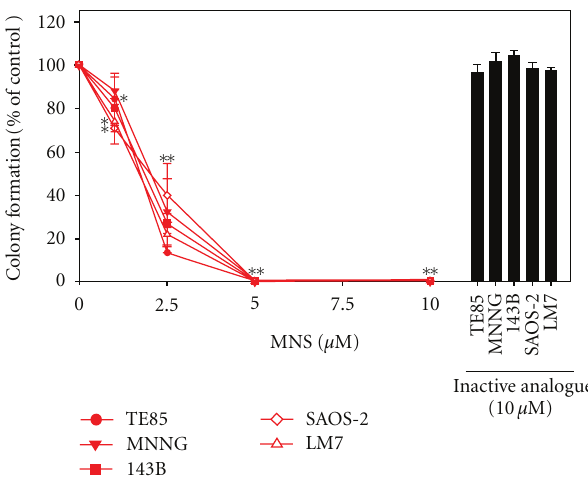
Figure 2: MNS reduced colony formation in a dose-dependent manner in the osteosarcoma cell lines. Colonies were counted 24 hours after plating in collagen gel in the presence of MNS, an inactive analogue, or 1% DMSO as a vehicle control. Data are represented as means ± SE of three independent experiments, each with three wells per group. Average colony formation per well for vehicle control groups were 141 for TE85 cells, 133 for MNNG cells, 187 for 143B cells, 152 for SAOS-2 cells, and 115 for LM7 cells. Asterisks denote P < 0 . 05 compared with the vehicle control group. Double asterisks indicate all cell lines were P < 0 . 05